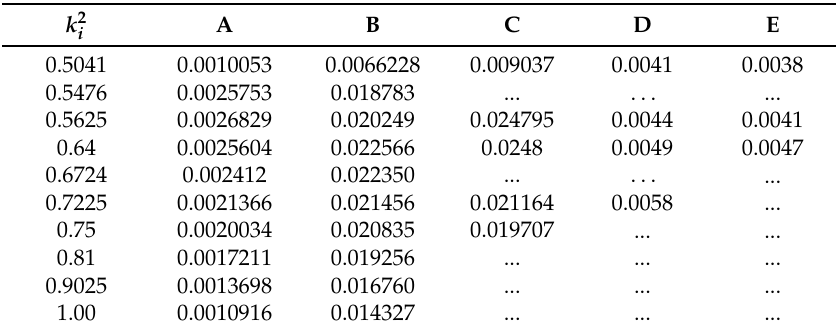
Table 5. Comparison of the present results for the positronium formation cross-section ( π a 2 those obtained in other